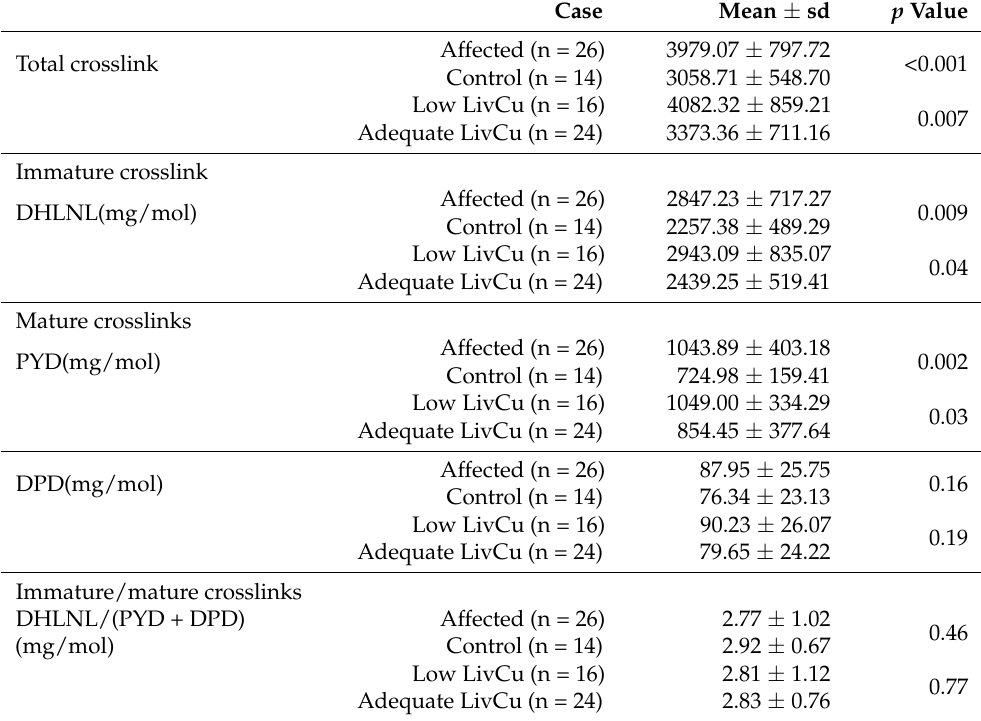
Table 4. Mean ± sd of total collagen crosslink content, DHLNL: dihydroxylysinonorleucine, PYD: pyridinoline, DPD: deoxypyridinoline, and DHLNL/(PYD + DPD) comparing humeral fracture status (affected vs. control) and liver Cu concentration status (low vs. adequate); LivCu: liver copper concentration. The crosslinks were normalised to the total HYP content (total crosslink in sample/total HYP in